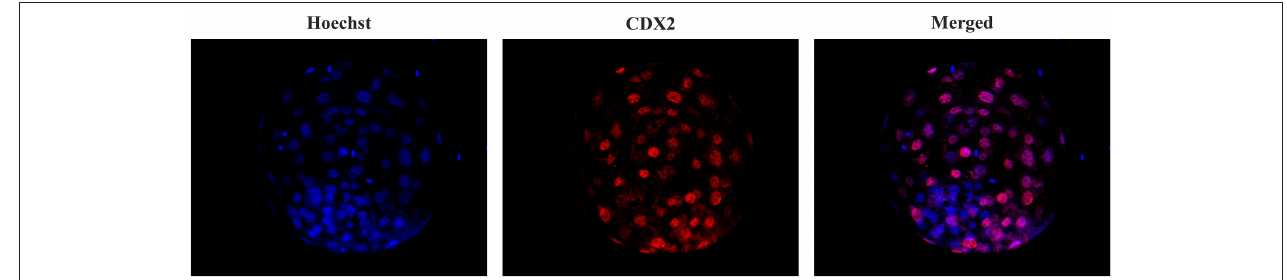
FIGURE 1 | Differential staining of blastocysts. Embryos were stained with Hoechst-33342 (blue fluorescence) for total cell staining and anti-CDX2 (red fluorescence) for trophectoderm cell staining. The merged image shows blue and pink fluorescence for inner cell mass nuclei and TE nuclei, respectively.